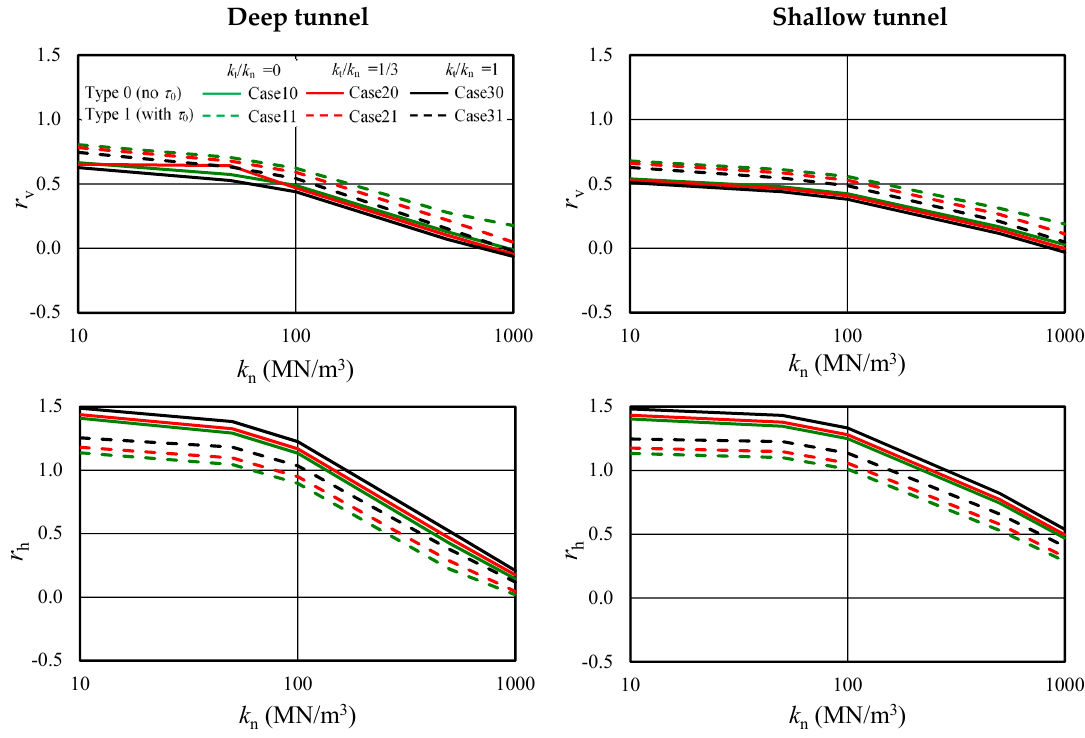
Figure 14. Support rate of initial effective earth pressure by lining in the vertical and horizontal direction r v , r h .